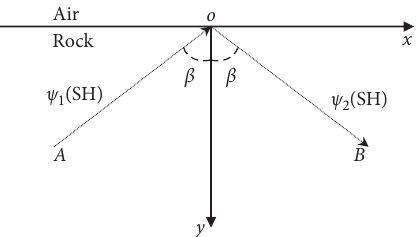
Figure 6: Propagation of acoustically emitted S-wave on rock